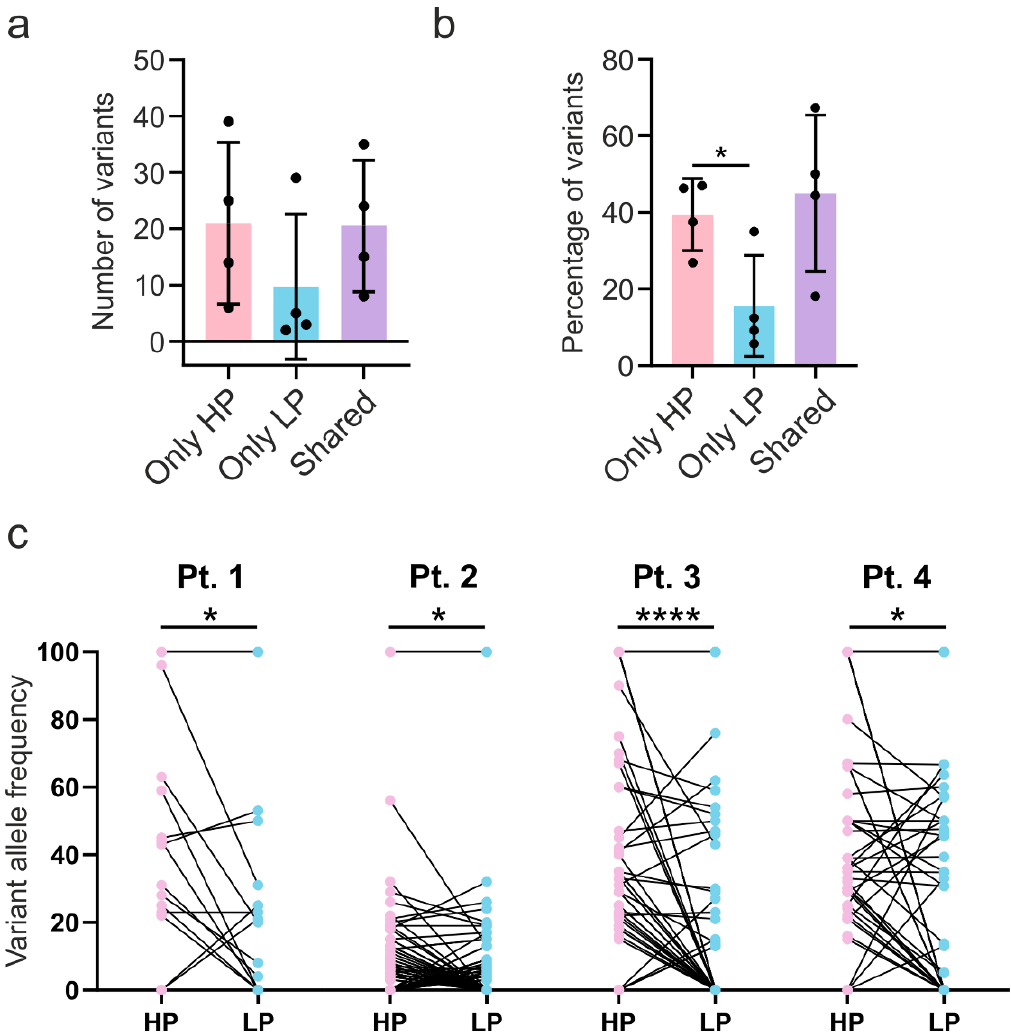
Figure 3. Higher mutation burden in high proliferation compartments. a,b. Number ( a ) and percentage ( b ) of variants detected only in high proliferation (HP) compartment, low proliferation (LP) compartment, and variants detected in both compartments (shared). p -value calculated using repeated-measures ANOVA with Tukey’s post-hoc test. ( c ) Variants’ allele frequency detected in high proliferation (HP) compartments compared to low proliferation (LP) compartments in each patient. p -value was calculated using paired t -test. * p < 0.05, **** p < 0.0001 Most of the mutations were detected only in HP compartments (Figure 4). Nonethe- less, shared variants detected in both HP and LP also constituted a substantial percentage of variants. In contrast, variants detected only in LP compartments were rare.